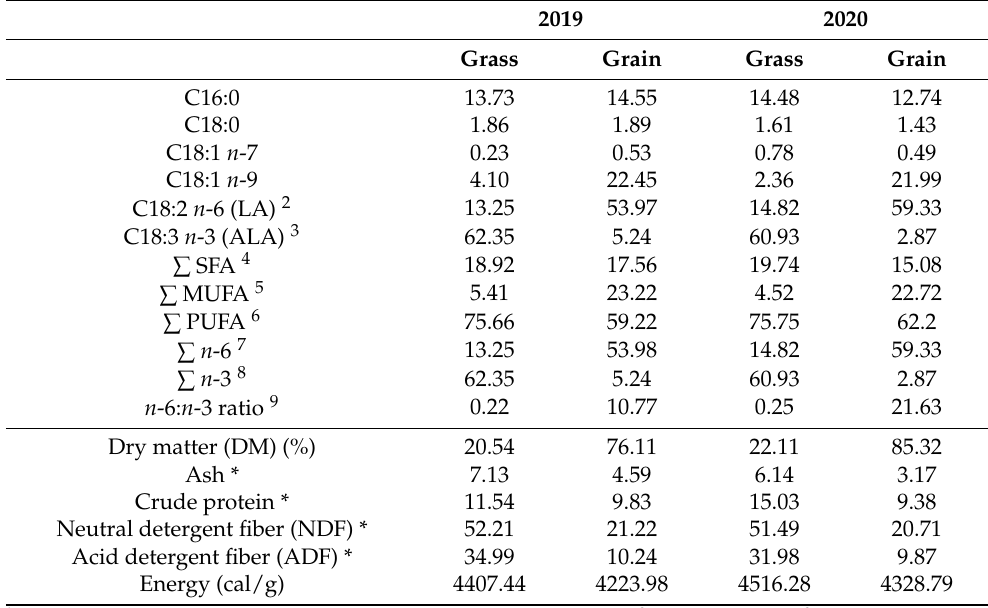
Table 1. Nutritive value of experimental diets (% of total fatty acids) 1